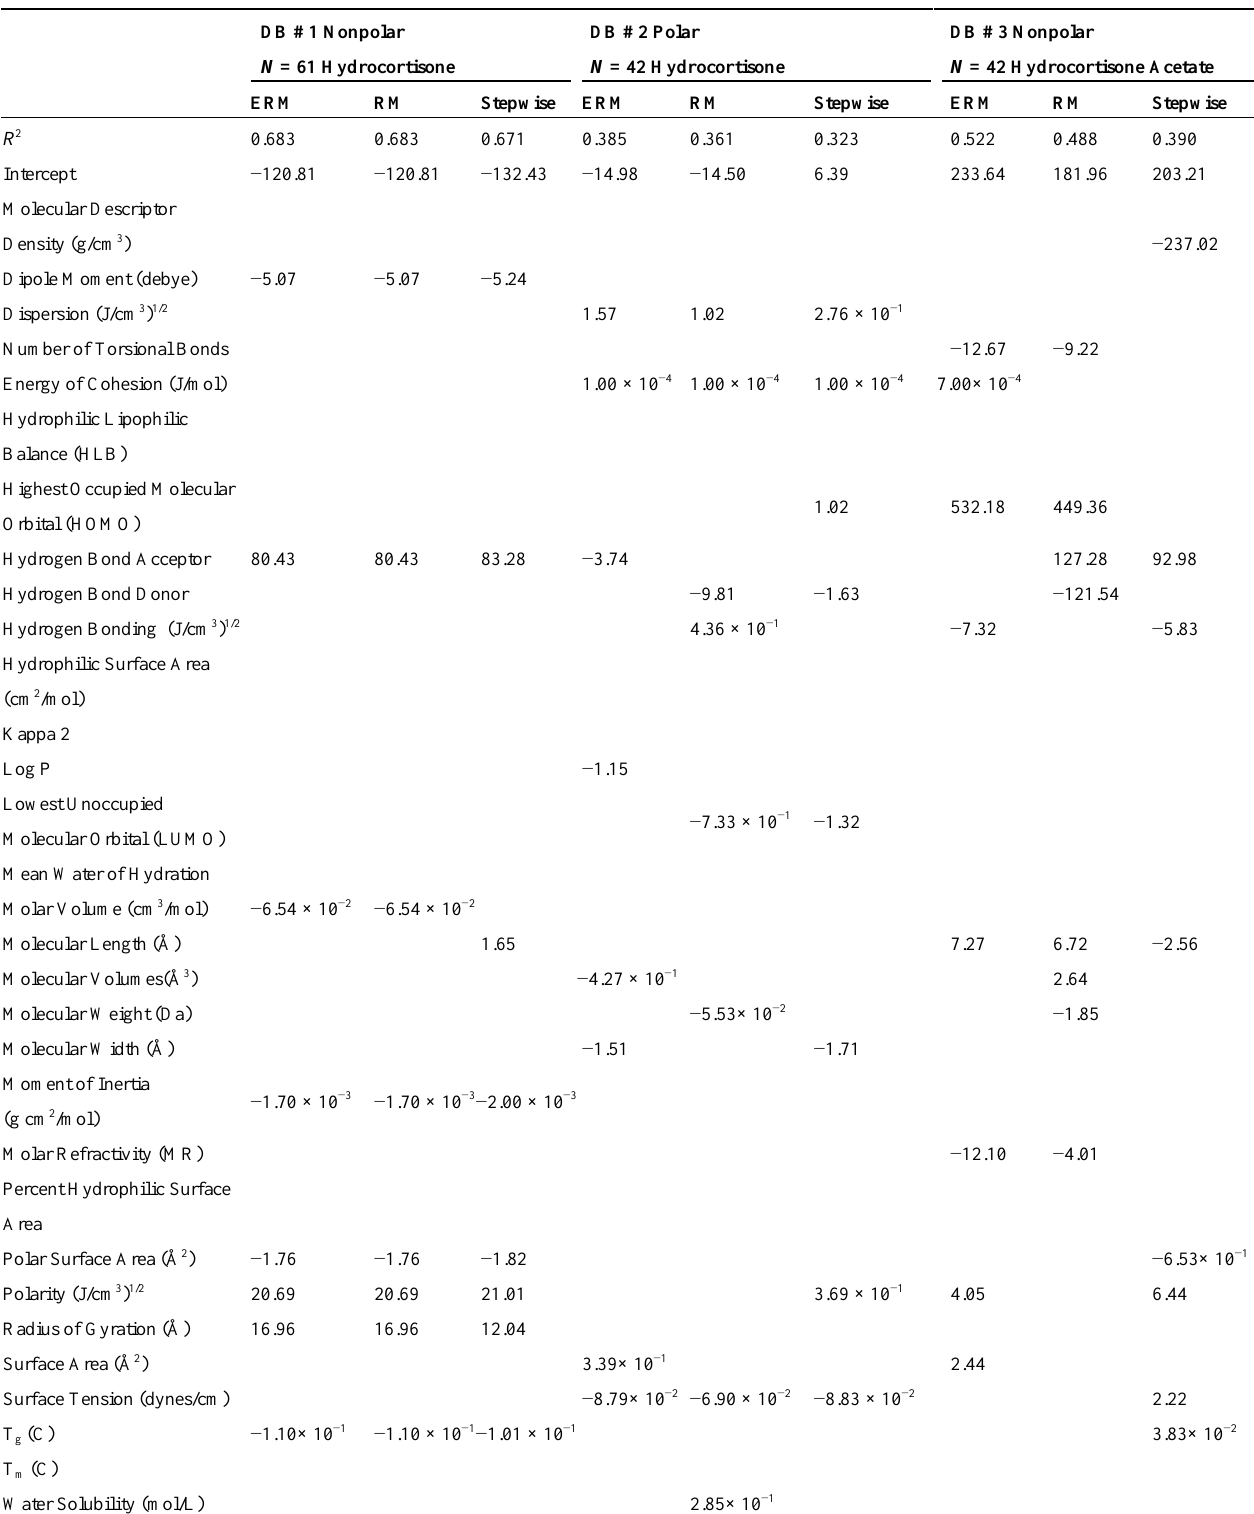
Table 1. Results of the ERM, RM and the forward stepwise selection procedure applied to the three datasets ( i.e. , DB #1, 2 and 3). Databases 1 and 2 were composed of 61 nonpolar and 42 polar enhancers, respectively, with hydrocortisone serving as a control molecule. Forty-two compounds were in the third database. The 2 R , y -intercepts and coefficients of the multiple linear models are